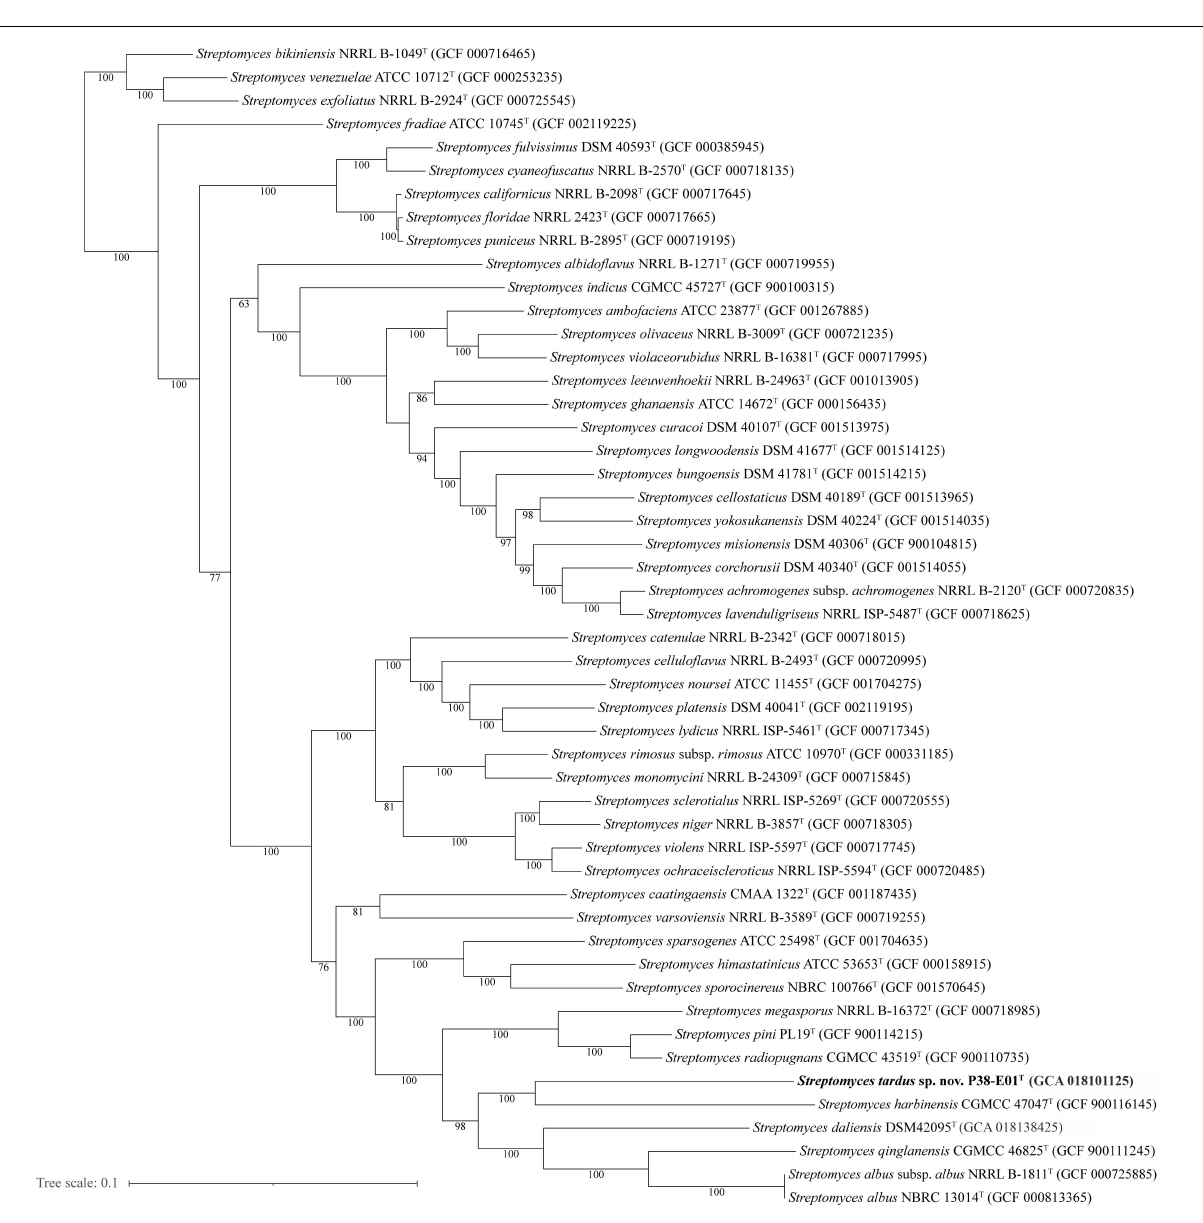
FIGURE 3 | Maximum likelihood tree generated by alignment of 100 core proteins using autoMLST (Alanjary et al., 2019) showing the relationship between S. tardus strain P38-E01 T (shown in bold) and 50 of the closest related taxa. Bootstrap values based on 1,000 replications are depicted at nodes, and only values > 50% are shown. Bar, 0.1 nucleotide substitutions per